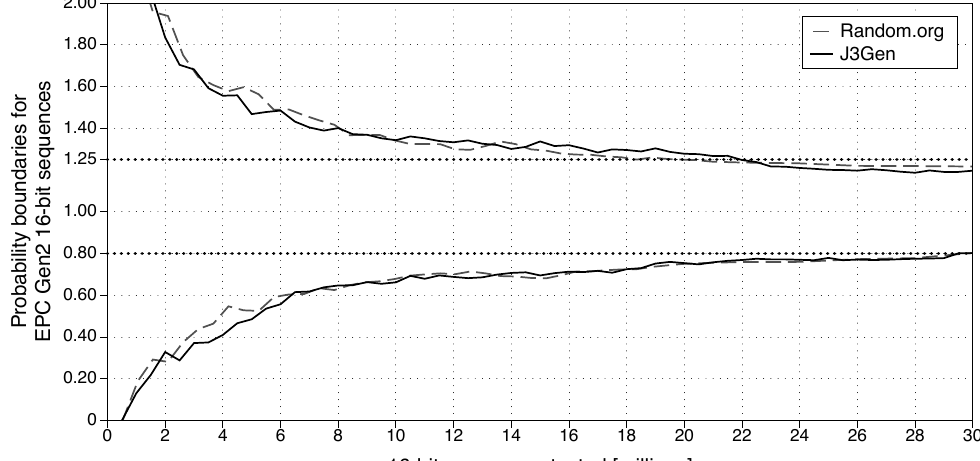
Figure 3. EPC Gen2 first randomness property test, achieving similar statistical results than Random.org true random